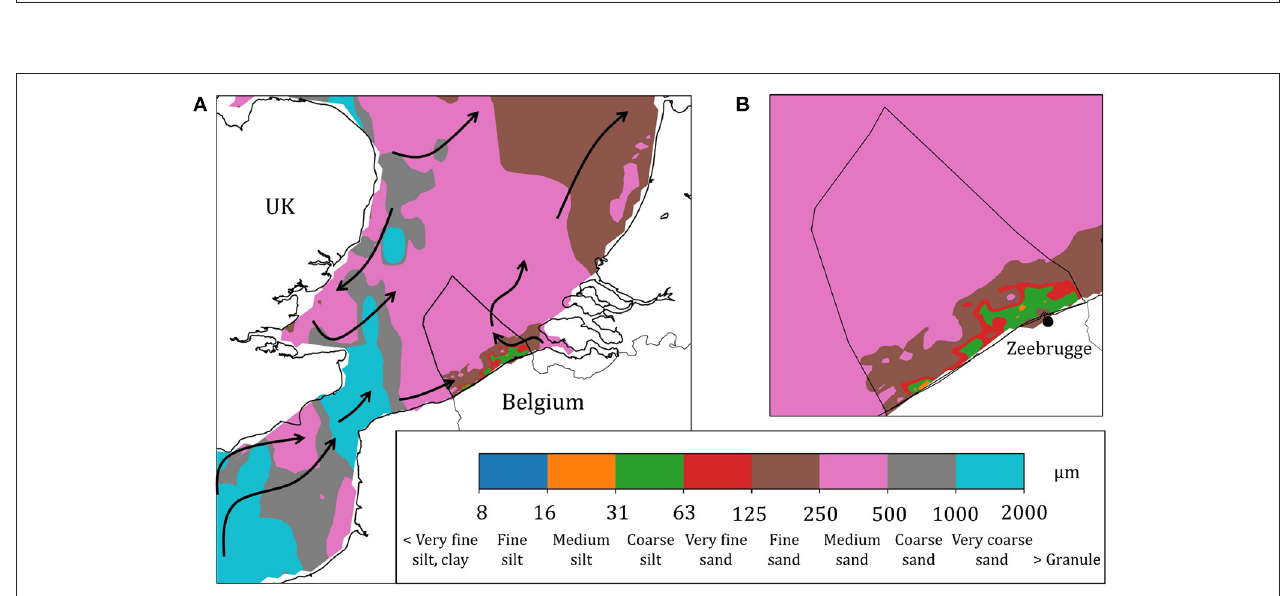
FIGURE 2 | Distribution of median sediment grain size [composed from Verfaillie and Van Lancker (2006), Wilson et al. (2018)] over the SBNS (A) and BCZ (B) with the residual currents (black arrows) superimposed for the SBNS.